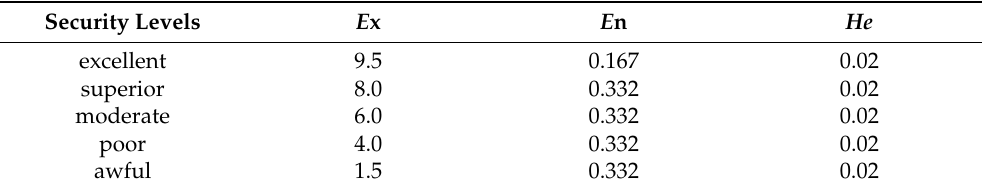
Table 3. Cloud feature values for different security levels, including three characteristic values: 𝐸x , 𝐸n, and 𝐻𝑒 .